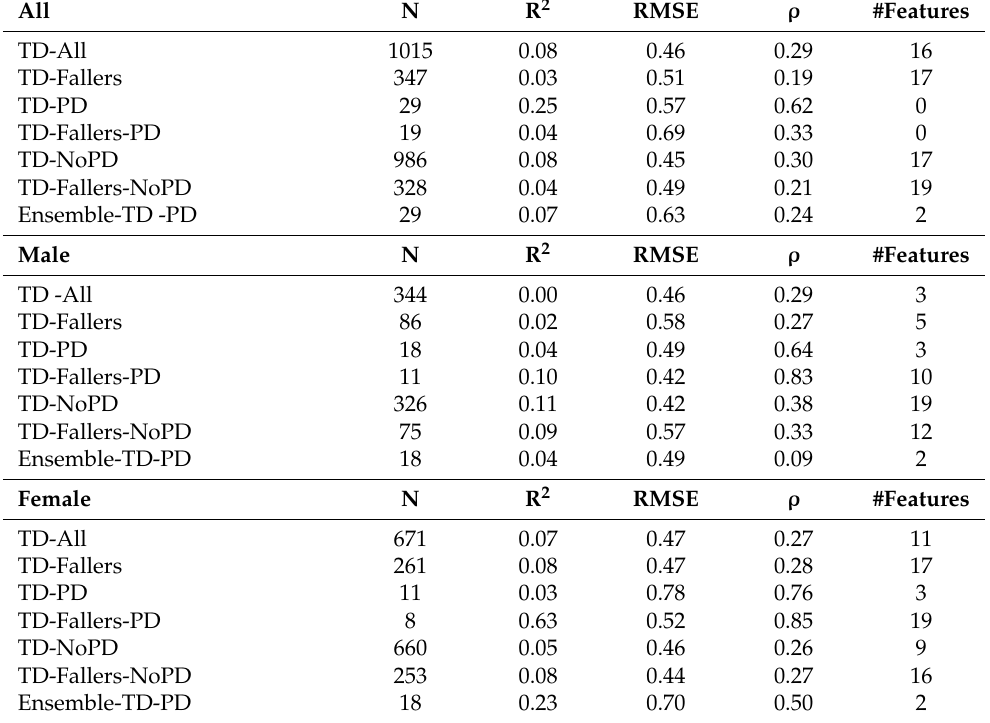
Table A5. Training set results for each Poisson regression model, selected using an elastic net procedure. Outliers ( NumFalls > 10) are removed to improve model fit.